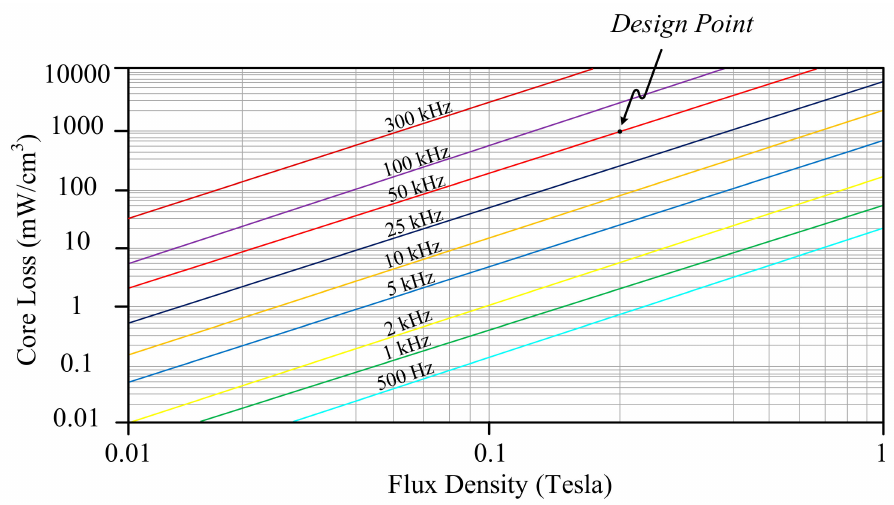
Figure 4. The relationship between core loss and flux density of Molypermalloy Powder (MPP) while permeability equals 125 µ